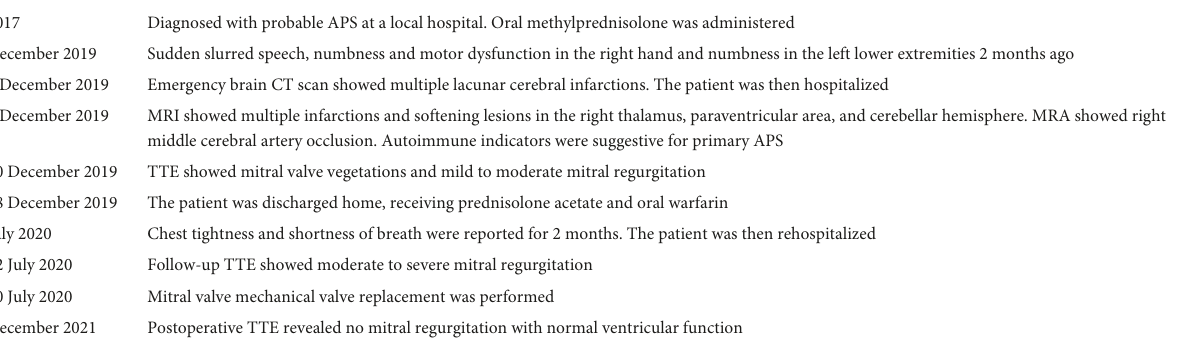
TABLE 1 Timeline of the patient’s clinical course.